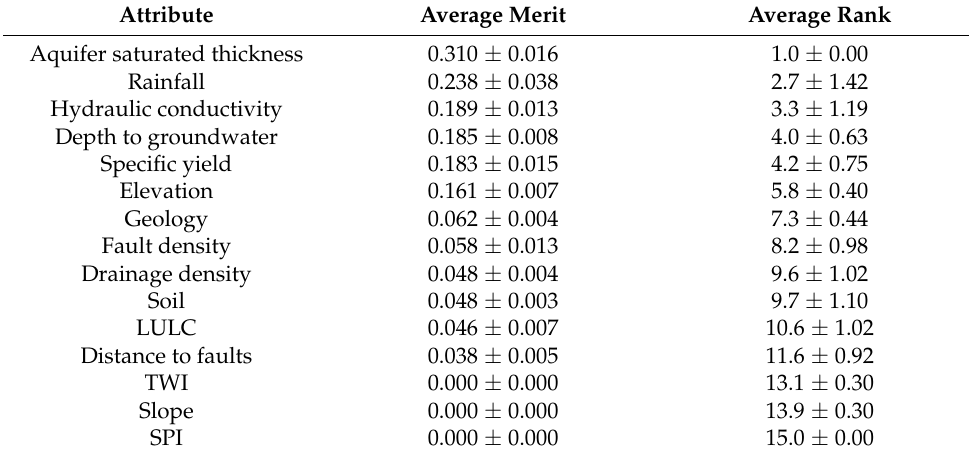
Table 2. Feature selection with information gain ratio (10-fold cross-validation).